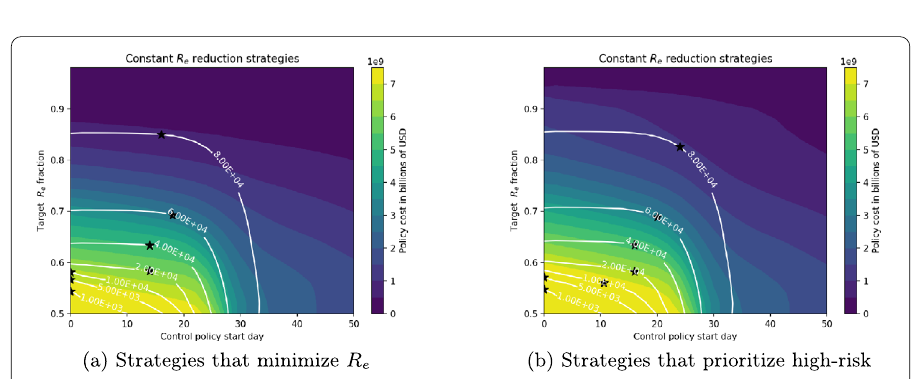
Figure 13 Deaths number and costs depending on target R e fraction and control starting day strategies